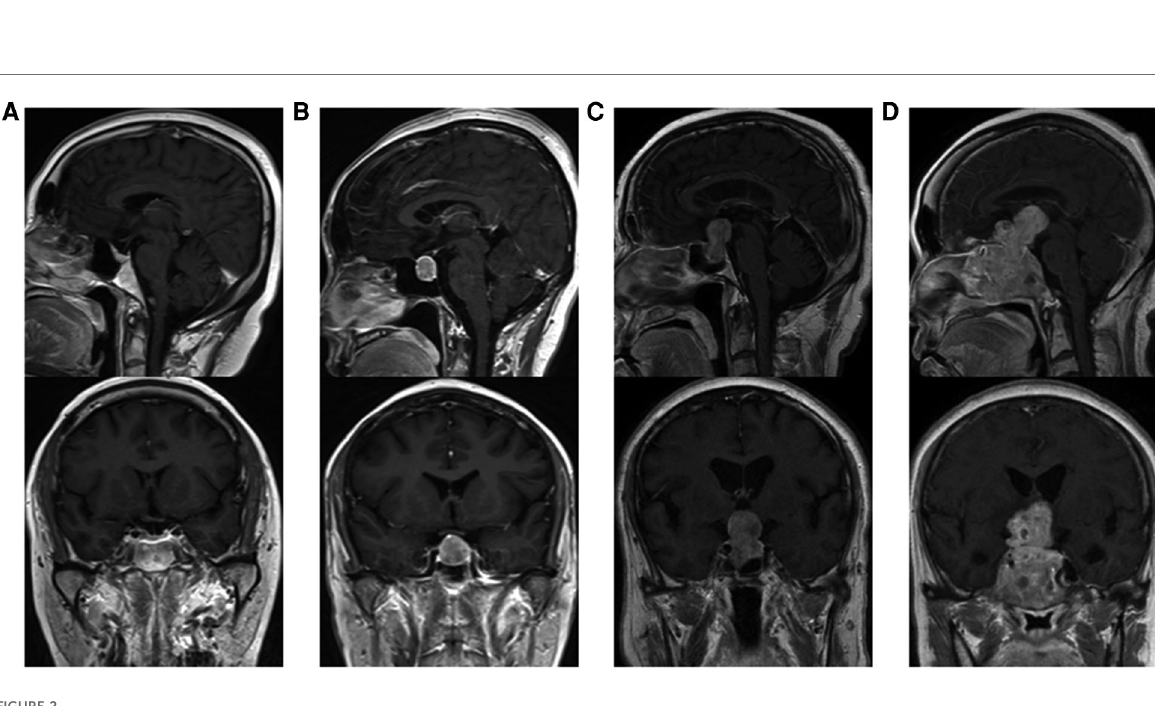
There were 191 female patients and 209 male patients. The average patient age at surgery was 48.5 years (11 – 82 years). The